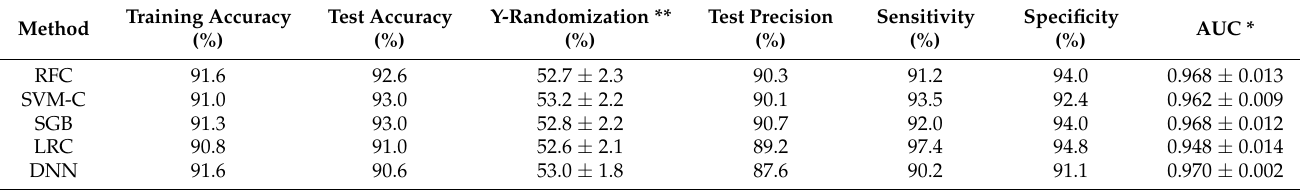
Table 1. Summary of results of classification of different machine learning methods. Training Accuracy Method